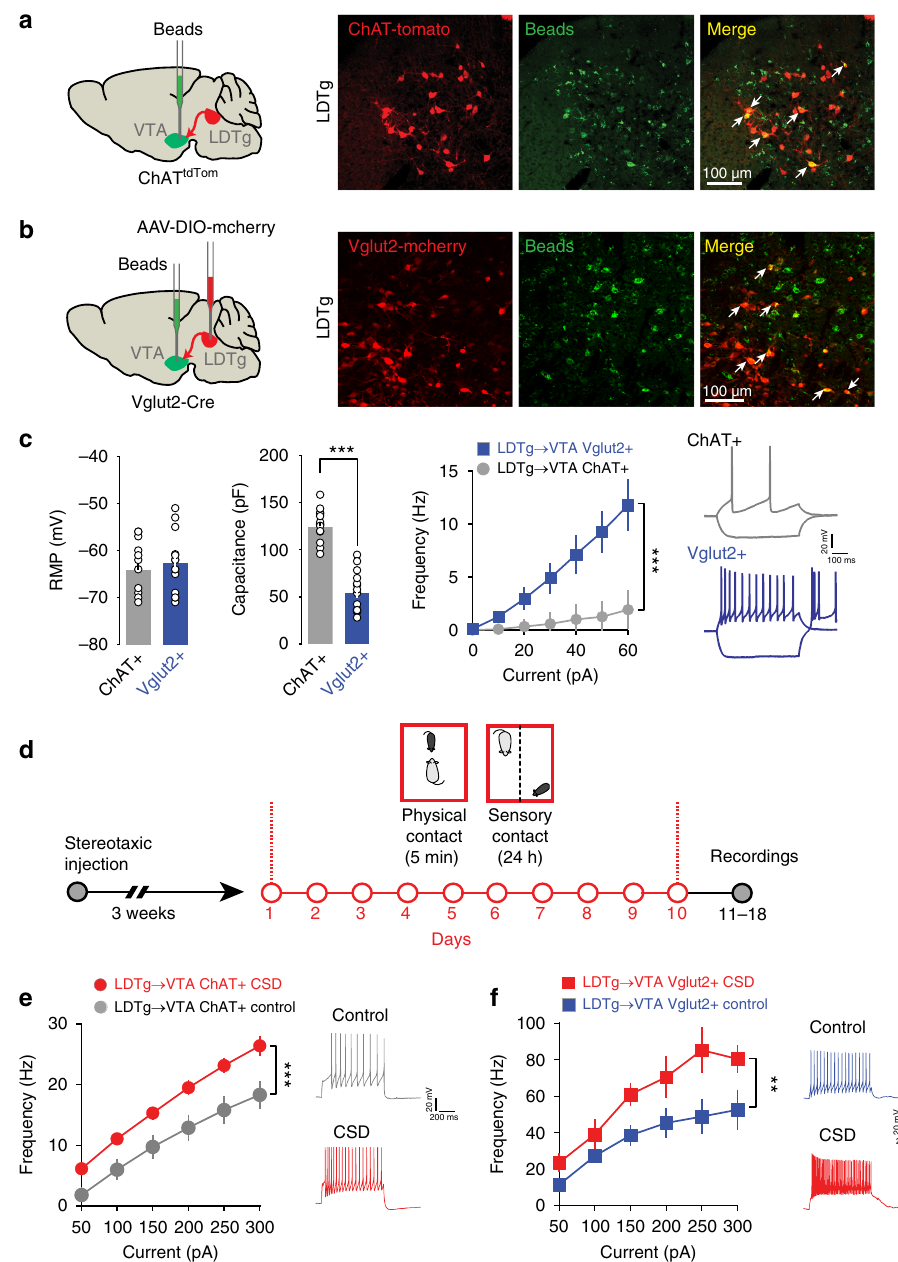
Fig. 2 Cholinergic and glutamatergic LDTg → VTA neurons are sensitive to chronic stress. a ChAT-Cre::tdTomato mice were injected with green retrobeads in the VTA. Confocal images show the co-expression of green beads and tdTomato in cholinergic neurons of the LDTg. b Vglut2-Cre mice were injected with an AAV8-hSyn-DIO-mcherry in the LDTg and green retrobeads in the VTA. Confocal images show the co-expression of green beads and mcherry in glutamatergic neurons of the LDTg. c Bioelectrical properties of cholinergic and glutamatergic LDTg → VTA neurons. Cholinergic neurons show bigger capacitance and lower fi ring frequencies at each current step injection (number of cell/mice: ChAT + = 15/4; Vglut + = 14/3). Interaction cell type × current F(6, 162) = 15.77, P < 0.0001; repeated-measures two-way ANOVA followed by Sidak ’ s comparisons test *** P < 0.001. Representative voltage traces showing response to current injection ( − 40 and + 60 pA) in both neuronal populations. d Schematic experimental time line to assess excitability in cholinergic and glutamatergic neurons after CSD. e Patch-clamp recordings in cholinergic LDTg → VTA neurons revealed increased excitability after CSD (number of cell/mice: ChAT + /Naive = 15/3; ChAT + /CSD = 15/4). Interaction treatment × current F(6, 168) = 19.23, P = 0.0001; repeated-measures two-way ANOVA followed by Sidak ’ s comparisons test *** P < 0.001. Representative voltage traces to a 300 pA current injection. f Patch-clamp recordings in glutamatergic LDTg → VTA neurons also shows increased excitability after CSD (number of cell/mice: Vglut + /Naive = 13/4; Vglut/CSD = 9/4). Interaction treatment × current F(18, 384) = 2.39, P = 0.001; repeated-measures two-way ANOVA followed by Sidak ’ s comparisons test, ** P < 0.01. Representative voltage traces to a 50 pA current injection. All plots depict mean ±